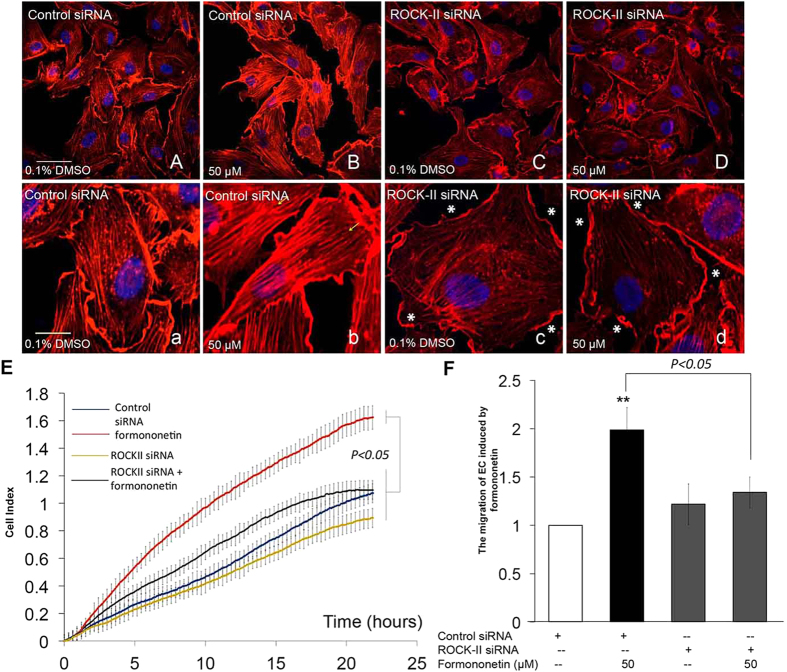
Inhibition of ROCK-II expression by ROCK-II siRNA abolished formononetin-induced stress fiber formation and cell migration in HUVECs.HUVECs transfected with non-specific siRNA were treated with (A,a) 0.1% DMSO or (B,b) 50 μM formononetin for 8 h to serve as negative and positive control, respectively. Cell nuclei were labeled with Hochest 33342 and F-actin was labeled with TRITC-phalloidin. Yellow arrowhead indicated stress fibers terminated at pointed edges. ROCK-II expression was inhibited in HUVECs by using ROCK-II siRNA and the cells were treated with (C,c) 0.1% DMSO or (D,d) 50 μM formononetin for 8 h. White asterisk indicated cortical actin complexes formed in HUVECs transfected with ROCK-II siRNA. White and yellow scale bars represent 50 μm and 20 μm respectively. (E) Real-time cell migration of HUVECs transfected with ROCK-II siRNA with or without formononetin treatments as detected by the xCELLigence system. HUVECs were transfected with ROCK-II siRNA for 2 days, followed by 0.1% DMSO or 50 μM formononetin for 24 h. (F) Statistical analysis of cell migration index of xCELLigence system following formononetin treatment for 20 h. Values are presented as the increment of migration ± SD (n = 3), for three independent experiments. **p < 0.01 vs. control.